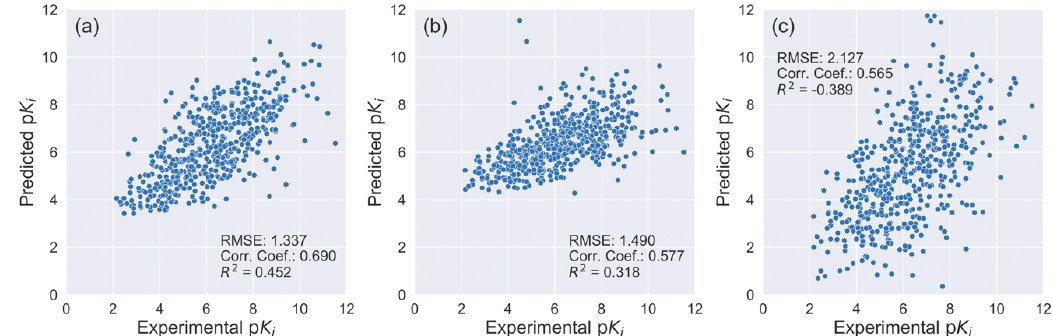
Figure 5. Binding affinity prediction results of protein-ligand complexes that are included in the PDBBind-2018 database but not in the PDBBind-2016: ( a ) AK-score, ( b ) X-Score, and ( c ) ChemPLP. The X-axis corresponds to experimental p K i values and the Y-axis to predicted values.